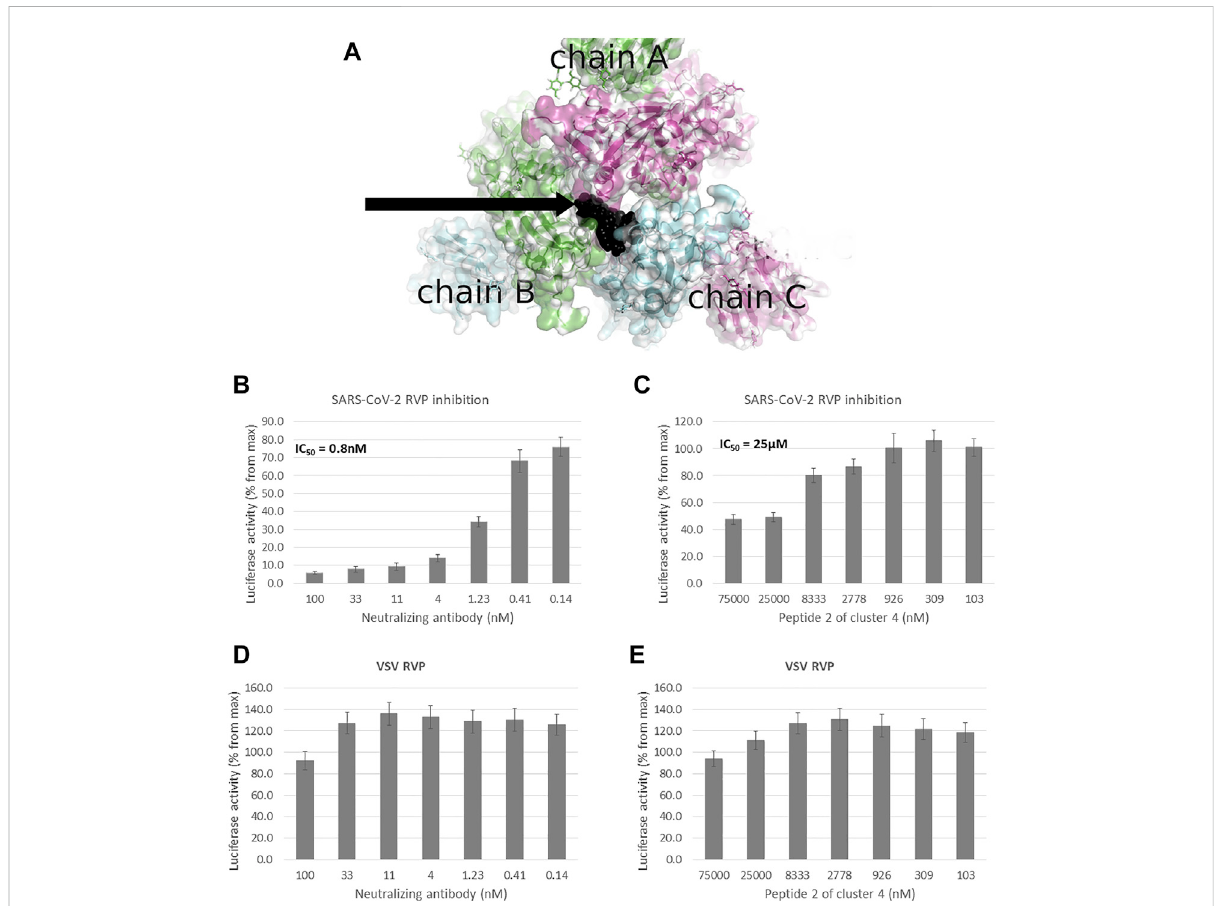
FIGURE 1 Peptidomimetic macrocycles screening for allosteric inhibitors. (A) Allosteric macrocycles were screened on the closed state spike structure (PDB:6VXX),IntheareaadjoiningtheRBDdomainsofchainA(green),chainB(blue)andchainC(purple).Thedockedmodelofcluster4,peptide2is showninblack.Toscreenmoleculesforinhibitoryactivity,SARS-CoV-2 Reportervirusparticles(RVP)wereused,withVSVRVPusedascontrol. (B) A commercial human monoclonal antibody shows an IC 50 of 0.8 nM, with (C) cluster 4, peptide 2 showing an IC 50 of 25 µM and incomplete inhibition. Neither the (D) antibody or (E) peptide show inhibitory activity against the VSV RVP (RVP data based on n = 2 biological replicates, 3 technical replicates per experiment, standard mean error (SEM) is represented for each